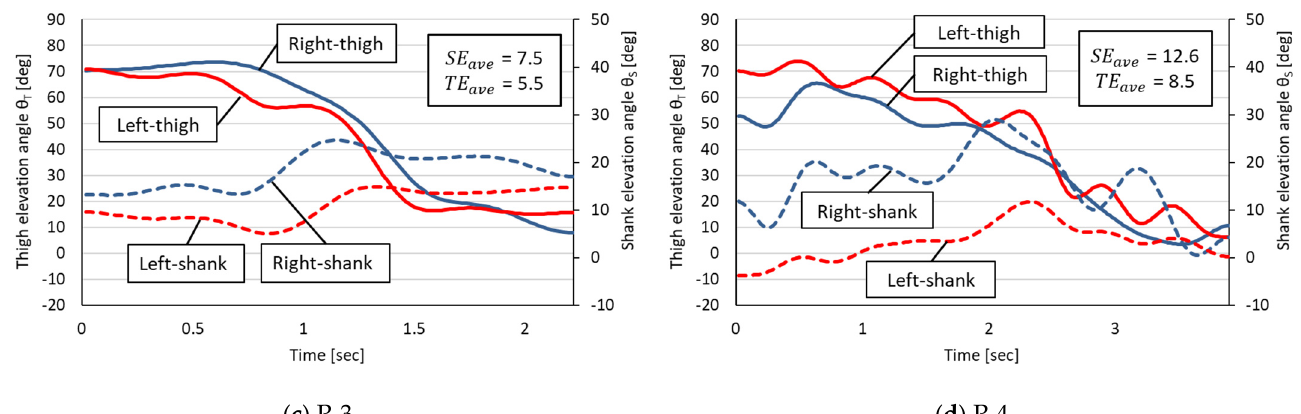
Figure 5. Measured angular changes in thigh and shank EAs in the rehabilitation patient group. The horizontal axis is the STS time (in seconds) of each participant. P-1 through P-4 in the figure refer to each rehabilitated patient in Table 1.